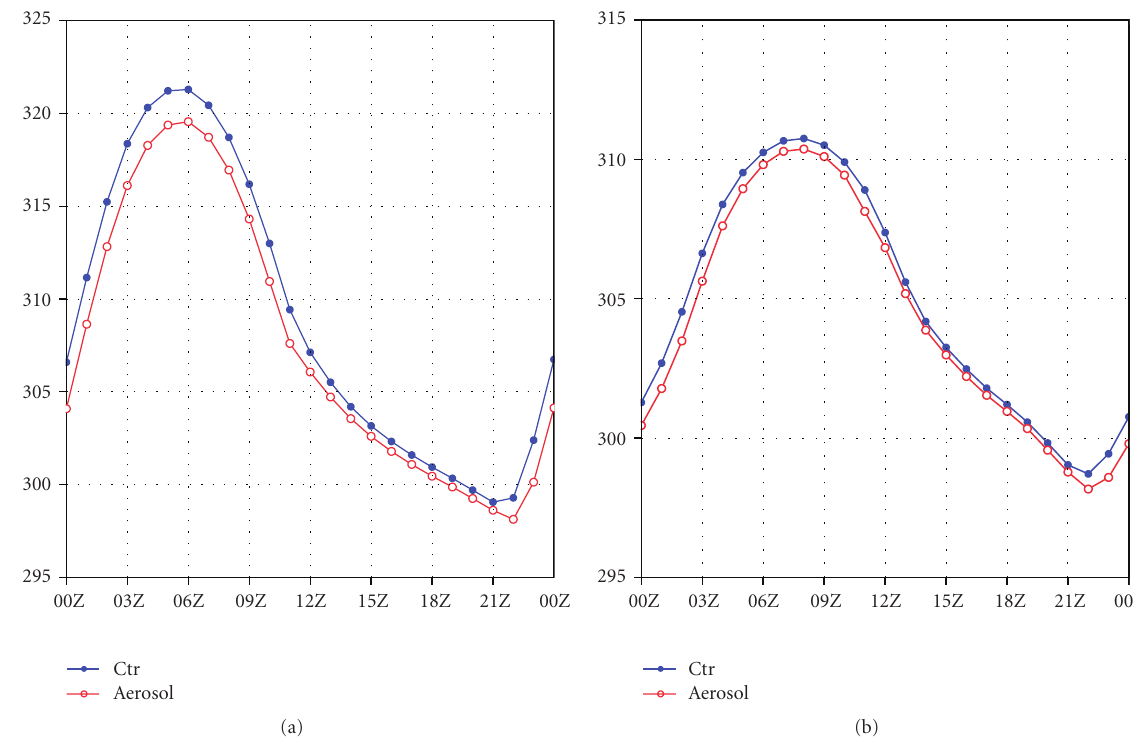
Figure 8: Aerosol e ff ects on (a) land surface skin temperature, and (b) land surface 2m air temperature. Model output for July 27, 2008. Averaged over Beijing (39.7–40.1 ◦ N, 116.1–116.7 ◦